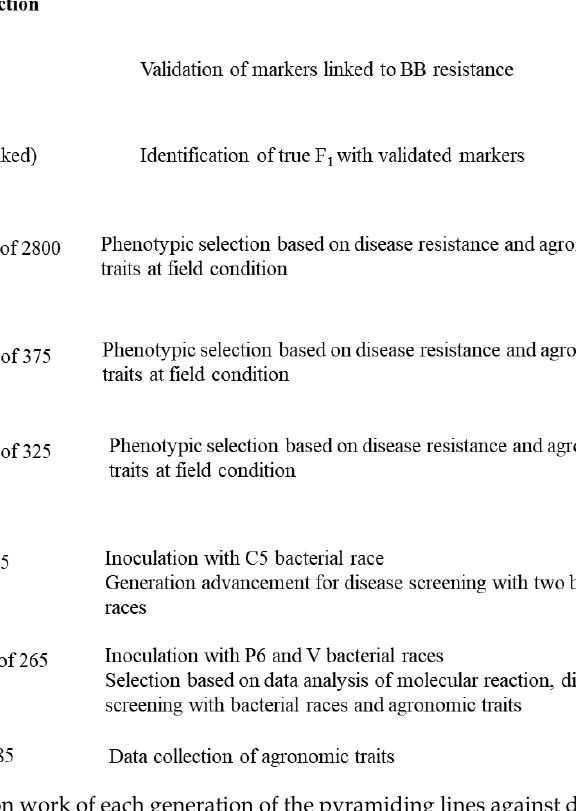
Figure 8. Rice breeding flowchart to illustrate the selection work of each generation of the pyramiding lines against different BB races.